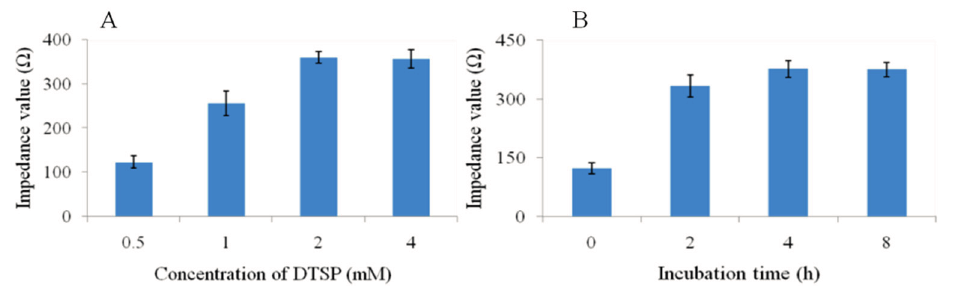
Figure 2. The effect of ( A ) the concentration of DTSP and ( B ) incubation time of DTSP on the impedance